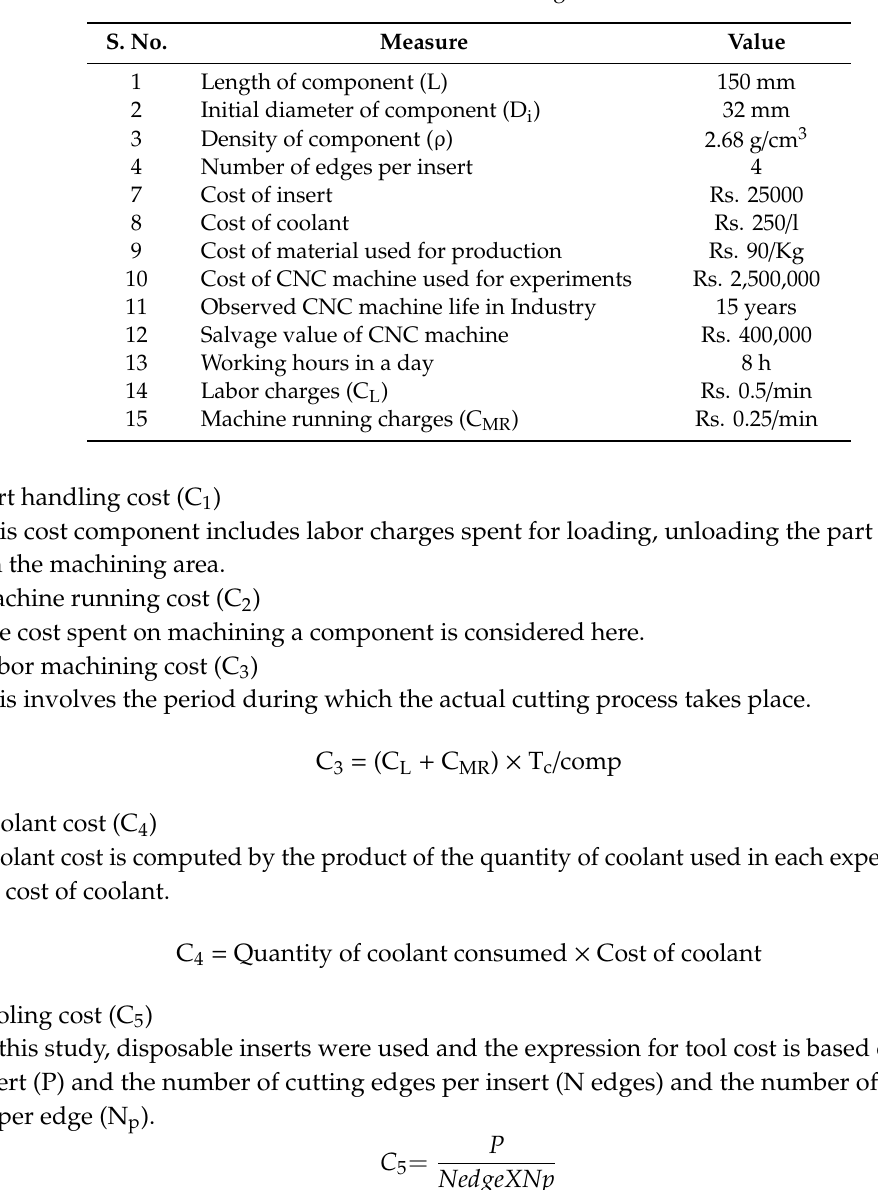
Table 3. Data used in machining